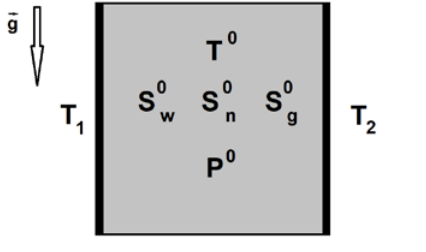
Fig. 1. The phases' redistribution problem statement.